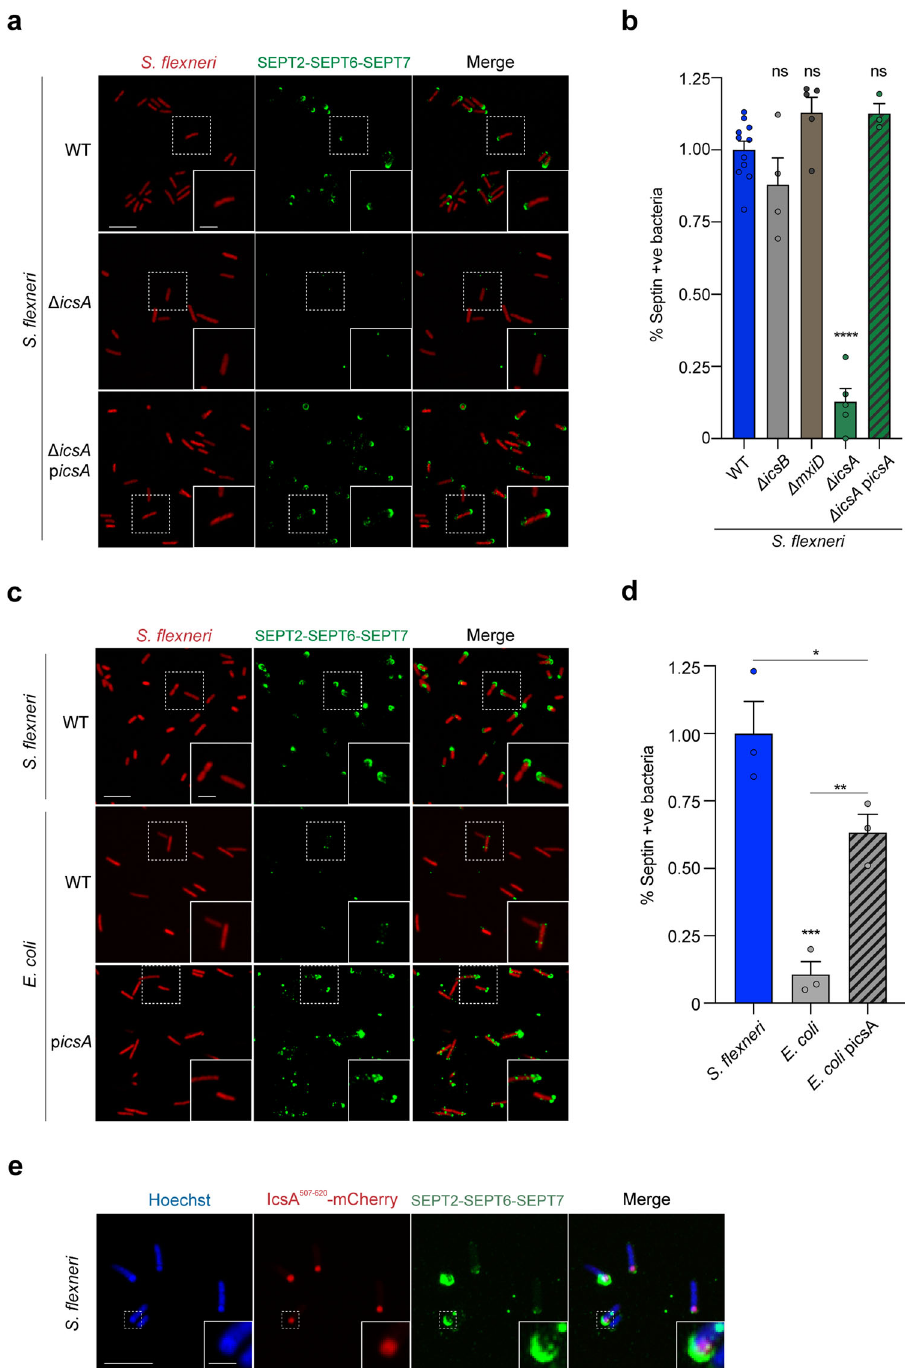
Fig. 2 Septins recognize IcsA on the outer membrane of S. fl exneri . a Airyscan confocal images showing the binding of septins in vitro to S. fl exneri WT (top), Δ icsA (middle), or Δ icsA complemented with icsA from a plasmid (bottom). Scale bar, 5 μ m (inset, 2 μ m). b Percentage of different bacterial strains recruiting septins in vitro normalized to S. fl exneri WT mean value. Data represent mean ± SEM from n = 2643 (WT), n = 1262 ( Δ icsA ), n = 2358 ( Δ icsB ), n = 1631 ( Δ mxiD ), and n = 880 ( Δ icsA + picsA) S. fl exneri cells distributed in at least 3 independent experiments. ns, non-signi fi cant with p = 0.270 ( Δ icsB ), p = 0.230 ( Δ mxiD ), and p = 0.254 ( Δ icsA + picsA), **** p < 0.0001 by one-way ANOVA and Dunnett ’ s post-test. c Airyscan confocal images showing the binding of septins in vitro to S. fl exneri WT (top), E. coli str. BL21 (middle), or E. coli str. BL21 complemented with icsA from a plasmid (bottom). Scale bar, 5 μ m (inset, 2 μ m). d Percentage of bacteria recruiting septins in vitro normalized to S. fl exneri WT mean value. Data represent mean ± SEM from n = 1073 ( S. fl exneri WT), n = 669 ( E. coli ), and n = 1132 ( E. coli + picsA) distributed in at least 3 independent experiments. * p = 0.0447, ** p = 0.0095, *** p = 0.0006 by one-way ANOVA and Tukey ’ s post-test. e Airyscan confocal images showing co-localization of septins and IcsA 507 – 620 -mCherry at the pole of S. fl exneri str. M90T. This experiment was performed 3 independent times. Scale bar, 5 μ m (inset, 1 μ m).